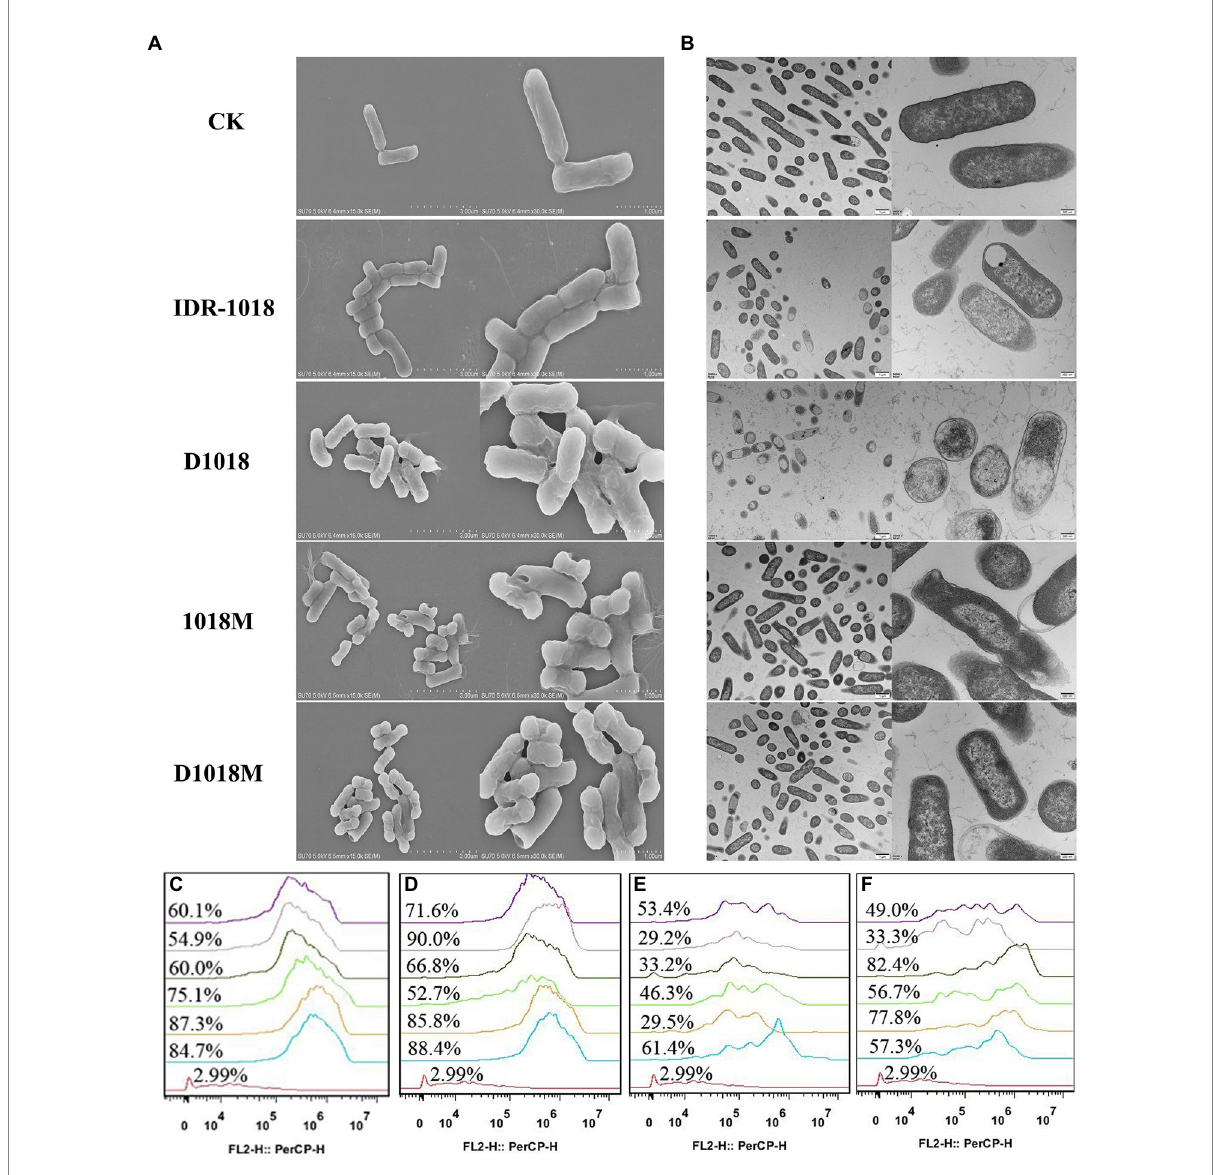
FIGURE 2 Effects of peptides on cell wall and membrane. (A) Scanning electron microscope. (B) Transmission electron microscope. Flow cytometric analysis of PI-staining in E. coli ATCC25922 cells treated with 1×, 2×, or 4× MIC IDR-1018 (C) , D1018 (D) , 1018M (E) , and D1018M (F) for 30 or 120 min, respectively. Red line: no peptide, negative control; Blue line: treatment with 1 × MIC peptides for 30 min; Orange line: treatment with 1 × MIC peptides for 120 min; Green line: treatment with 2 × MIC peptides for 30 min; Dark green line: treatment with 2 × MIC peptides for 120 min; Pink line: treatment with 4 × MIC peptides for 30 min; Purple line: treatment with 4 × MIC peptides for 120